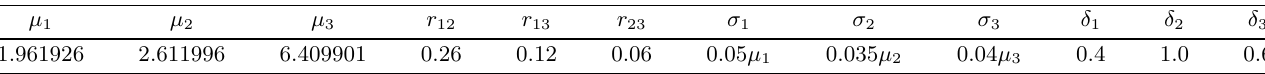
Table 1. Parameters for a generating a non-Gaussian pressure balance joint PDF model using a multivariate skew- normal distribution .